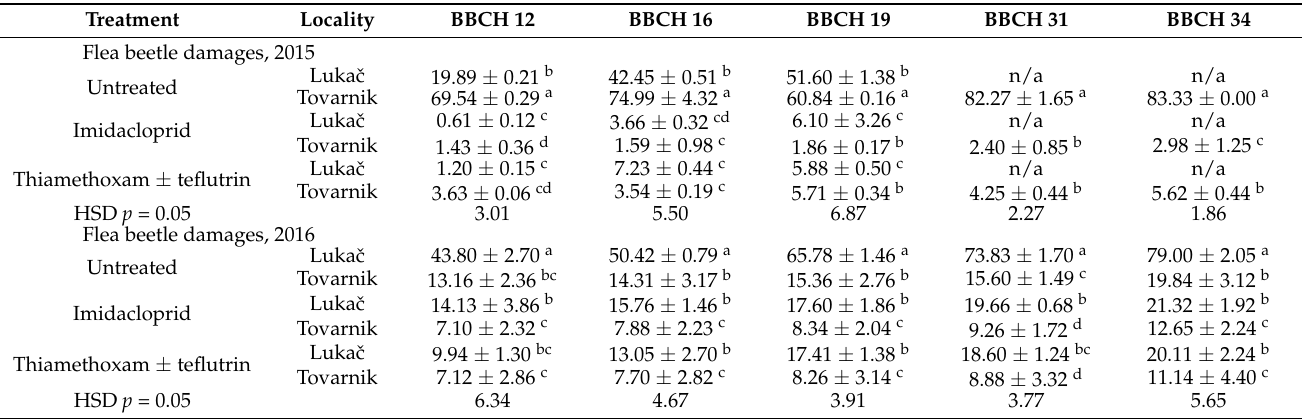
Table 3. Sugar beet flea beetle damage (according to Towsend-Heuberger) on sugar beet plants in different developmental stages (BBCH).